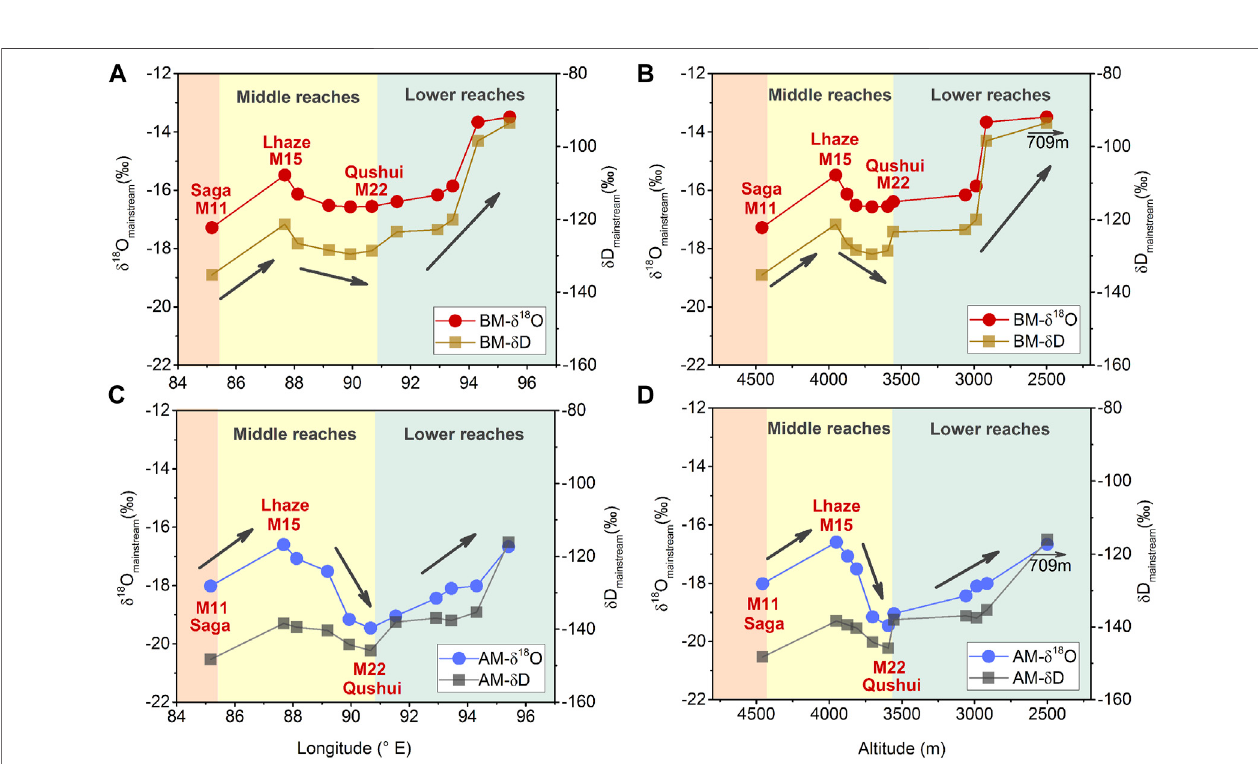
FIGURE 3 | Mainstream water spatial variation of δ 18 O and δ D values of characteristics with longitude (A,C) and altitude (B,D) . Red circles and brown squares represent δ 18 Oand δ Dvaluesbeforemonsoonprecipitation(BM)in (A,B) ,respectively.Bluecirclesandgraysquaresrepresent δ 18 Oand δ Dvaluesofmainstreamwater after monsoon precipitation (BM) in (C,D) . In the upper part of the middle reach, δ 18 O shows abnormally high values.